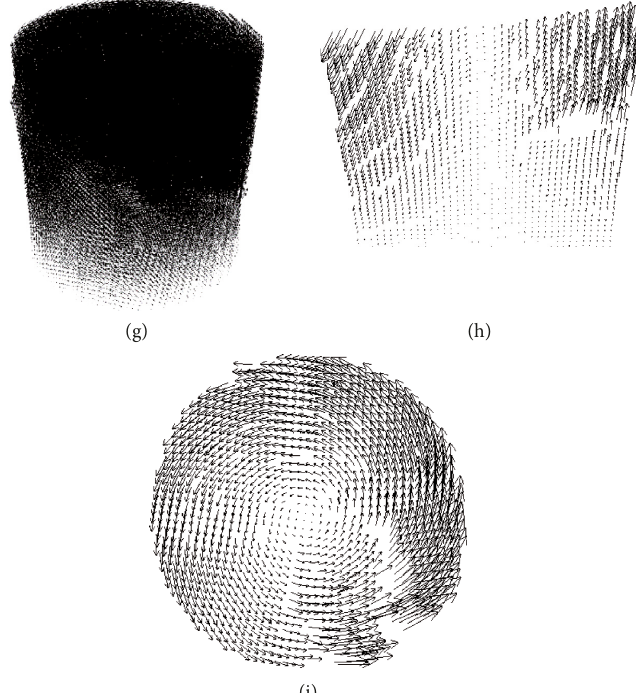
Figure 17: Later stage of the loading period (appearance of crack). (a) Stress distribution (entire model). (b) Stress distribution (vertical section). (c) Stress distribution (transverse section). (d) Contact distribution (entire model). (e) Contact distribution (vertical section). (f) Contact distribution (transverse section). (g) Displacement field (entire model). (h) Displacement field (vertical section). (i) Displacement field (transverse